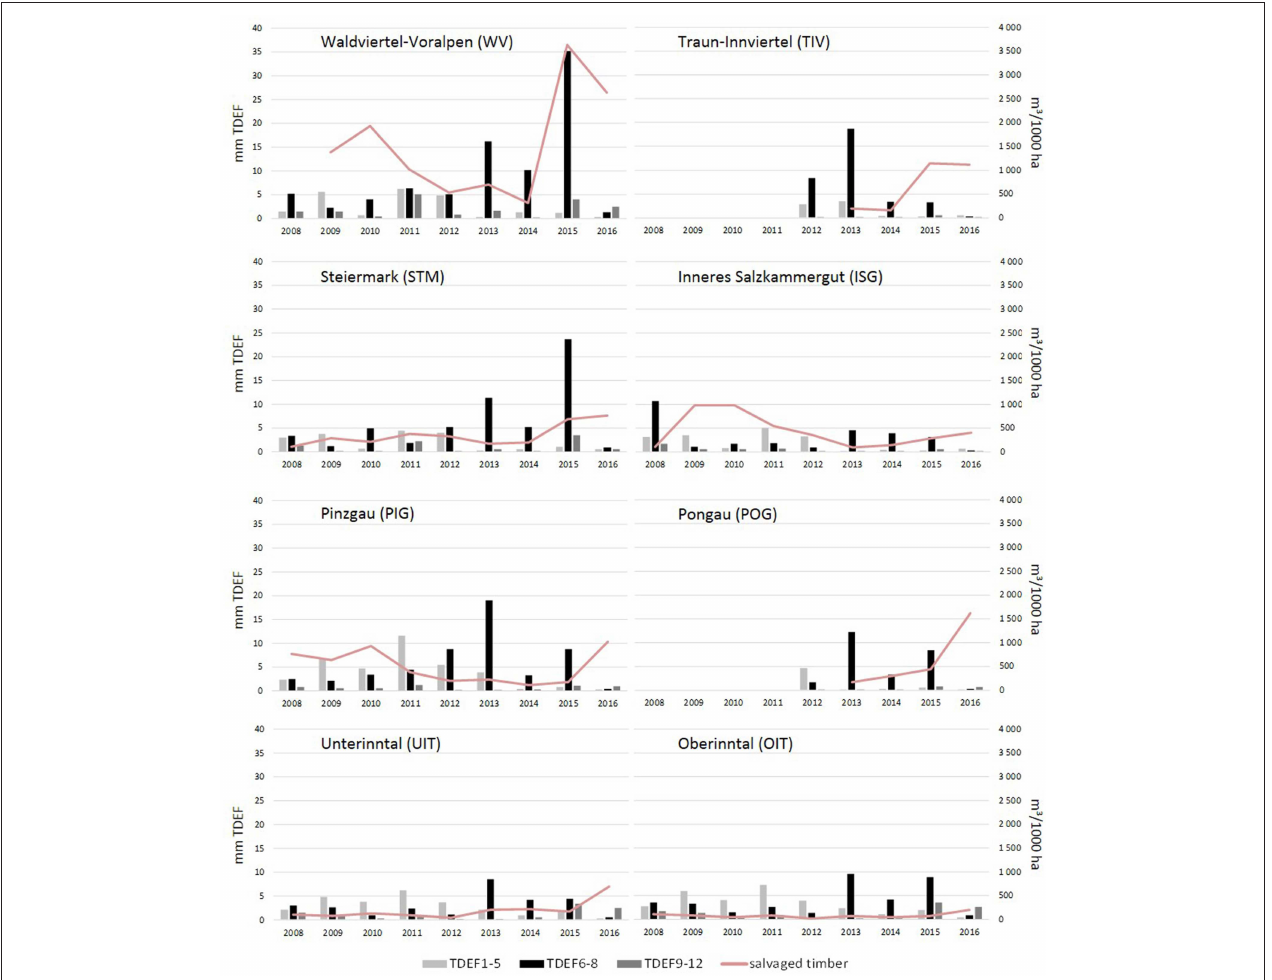
FIGURE 2 | Drought stress and bark beetle attack in eight Austrian Federal Forests (ÖBf) forest enterprises (2008–2016): mean transpiration deficits in mm per periods January–May (TDEF1-5), June–August (TDEF6-8), September–December (TDEF9-12), and amount of timber salvaged due to bark beetle attack in m 3 /1,000 ha Norway spruce stands